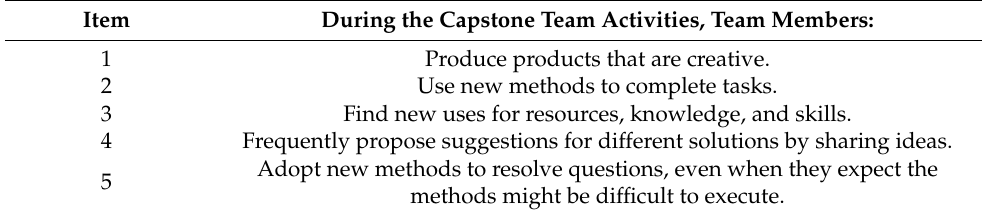
Table 2. Example Statements of Items for the Team Creativity